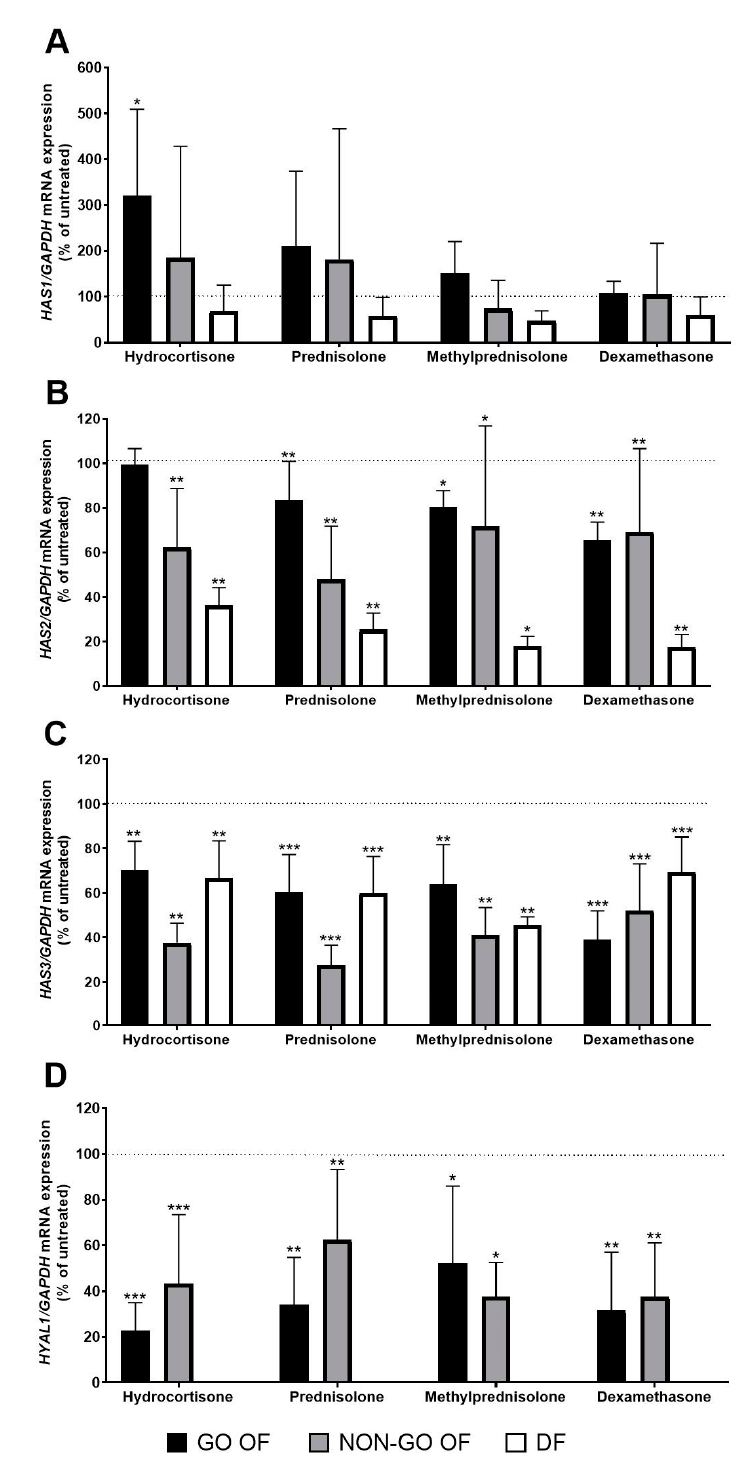
Figure 2. The effect of GCs (1 µ M) on ( A ) HAS1 , ( B ) HAS2 , ( C ) HAS3 and ( D ) HYAL1 mRNA expression of OFs and DFs. Data were analyzed using a repeated measure ANOVA followed by Dunnett’s test. The dotted line at 100 % represents the mRNA expression of untreated cultures. Results shown are the mean ± SEM. * p < 0.05, ** p < 0.01, *** p < 0.001. GO OF—Graves’ orbitopathy fibroblasts, NON-GO OF—control orbital fibroblasts, DF—dermal fibroblasts, HAS1 —hyalu ‐ ronan synthase 1, HAS2 —hyaluronan synthase 2, HAS3 —hyaluronan synthase 3, GAPDH — glyceraldehyde 3 ‐ phosphate dehydrogenase, HYAL1 —hyaluronidase 1 . The origin of the cells did not affect the response to PDGF ‐ BB treatment (GO vs. NON ‐ GO: p = 0.593, DFs vs. OFs: p = 0.995), and PDGF ‐ BB increased HA production in all cultures ( p < 0.0001). GC treatment reduced HA production even under PDGF ‐ BB ‐ stimu ‐ lated conditions ( p < 0.0001), and the effect was cell ‐ origin ‐ dependent ( p = 0.004); it was more intense in DFs. As shown in Figure 3, all types of GC were able to decrease the